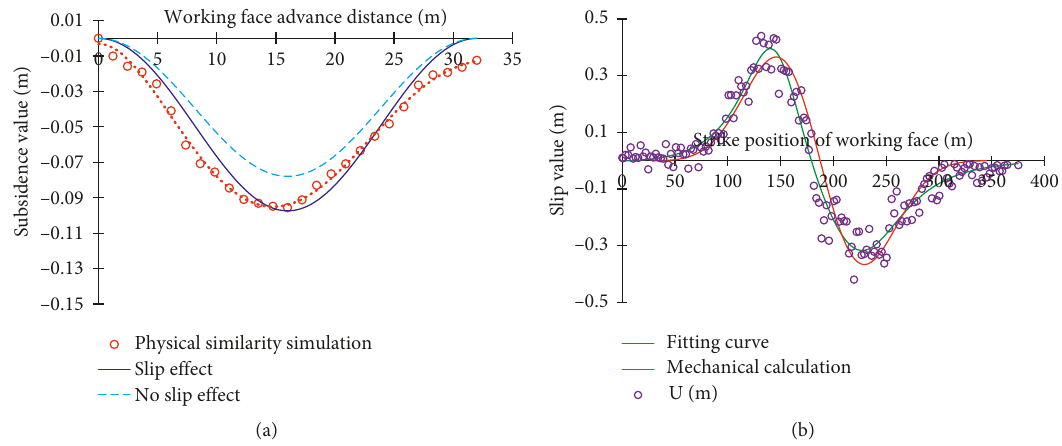
Figure 16: Comparison between theoretical calculation and physical simulation. (a) Contrast curves of subsidence amount. (b) Horizontal slip curves between theoretical calculation and similarity simulation.